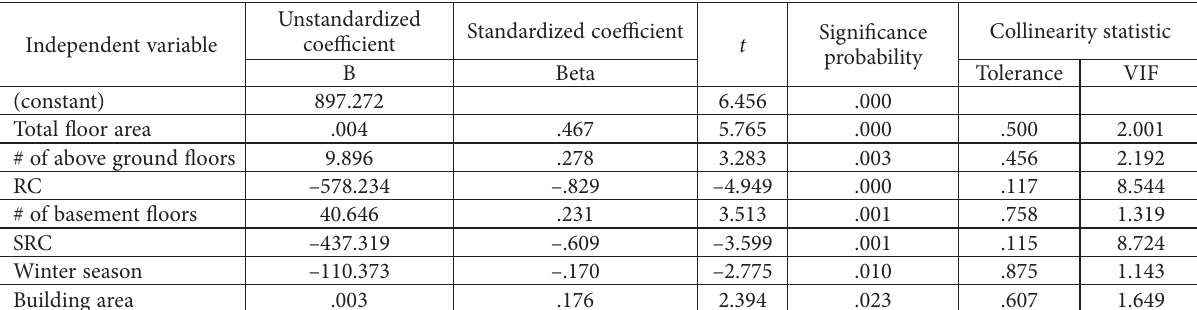
Table 12. Multiple linear regression analysis using the stepwise selection method –